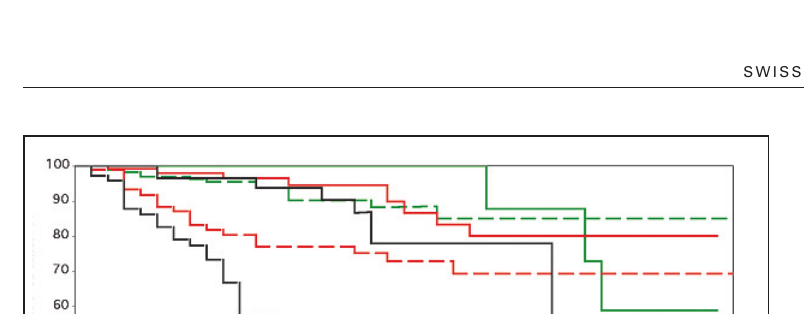
3–6 cm Placebo (11events) 3–6 cm Imatinib (4 events)